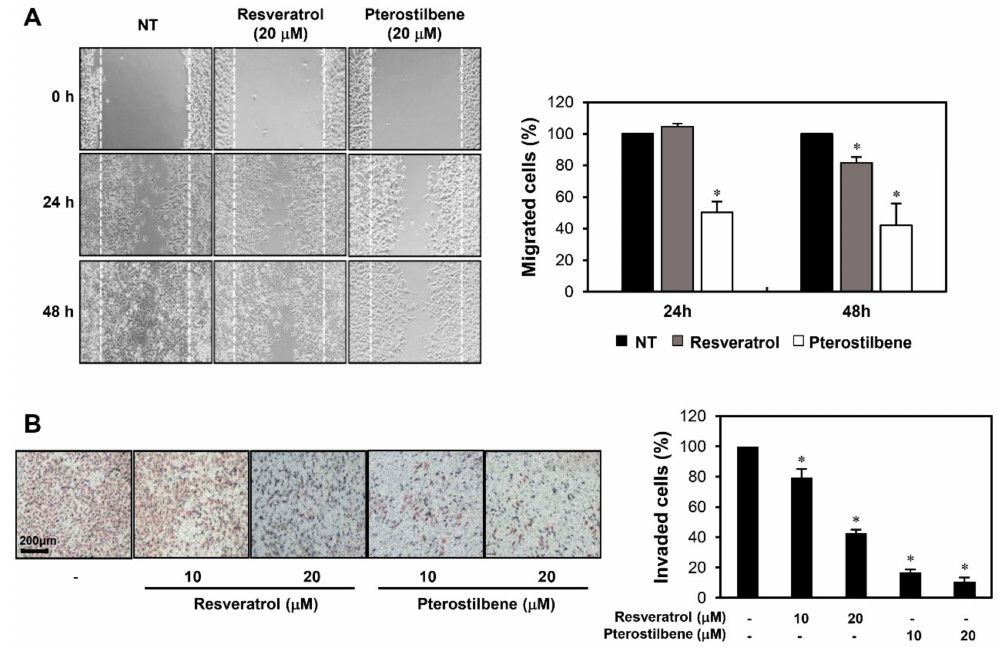
Figure 3. E ff ects of resveratrol and pterostilbene on the metastatic ability of HeLa cells. ( A ) The e ff ects of resveratrol and pterostilbene on the migration of HeLa adherent cells. The migratory potential of HeLa cells was analyzed using a wound healing assay. The cells were incubated in the absence or presence of the two compounds (20 µ M) for 48 h. The cells that migrated into the gap were counted using an optical microscope. Dotted white lines indicate the edge of the gap at 0 h. ( B ) The e ff ects of resveratrol and pterostilbene on the invasion of HeLa adherent cells. The invasiveness of HeLa cells was analyzed using Matrigel-coated polycarbonate filters. The cells were incubated in the absence or presence of the two compounds (10 and 20 µ M) for 48 h. The cells penetrating the filters were stained and counted using an optical microscope. * p < 0.05 versus the